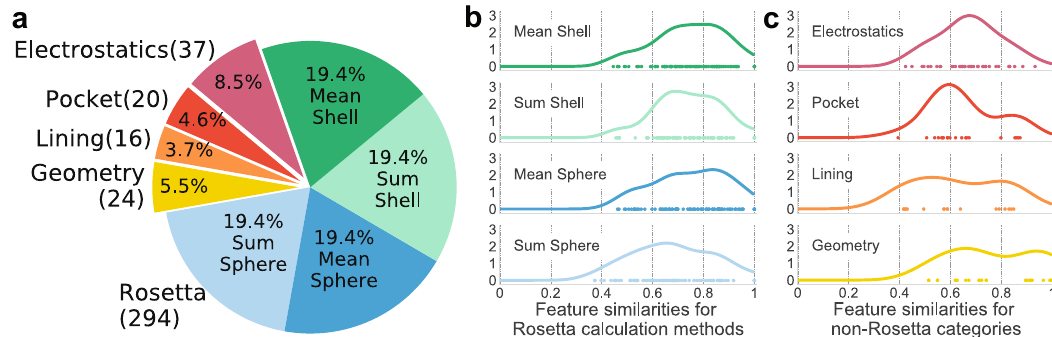
Fig. 2 Relative size of feature categories and feature similarity distributions. a Distribution of features used for training. The four groups of Rosetta terms each include 84 features calculated in one of four ways — the mean or average of residues within four shells or spheres — for a total of 294 unique Rosetta category features since the fi rst shell and sphere are the same. b , c The kernel density estimations of feature similarity between enzymatic and non-enzymatic sites for each Rosetta calculation method ( b ) and the other four feature categories ( c